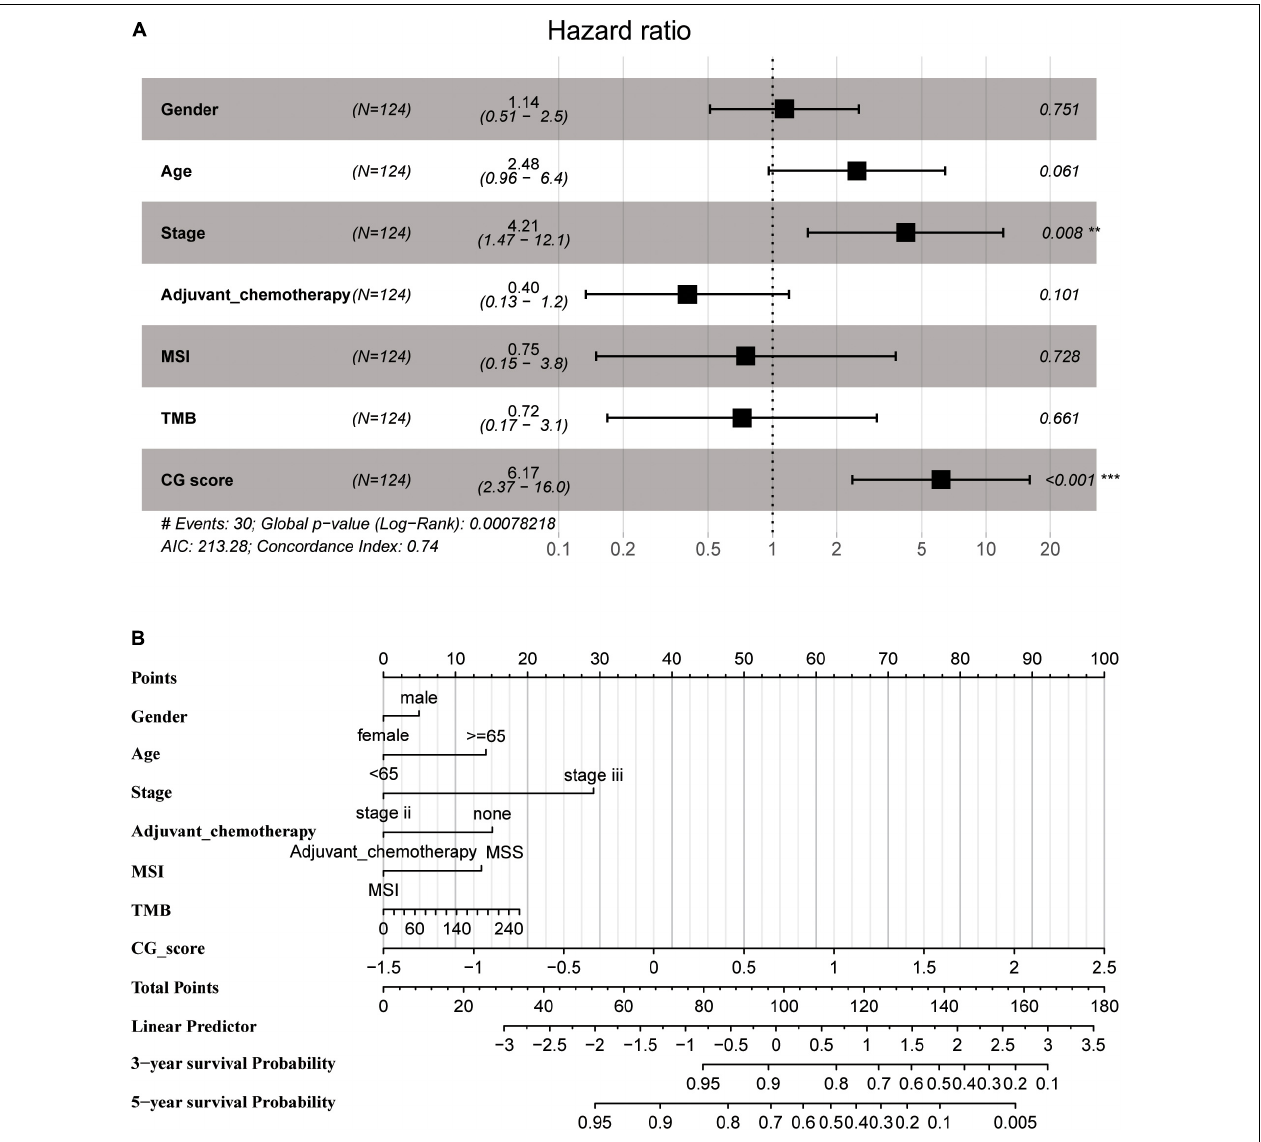
FIGURE 5 | (A) Multivariate Cox regression analysis depicting the association of the methylated signature with the survival of stage II/III CRC patients in the training group. (B) The nomogram prediction model was developed by integrating CG Score with the clinical features in the training group. CRC, colorectal cancer; MSI, microsatellite instability; TMB, tumor mutational burden; CG score, CG site-based risk